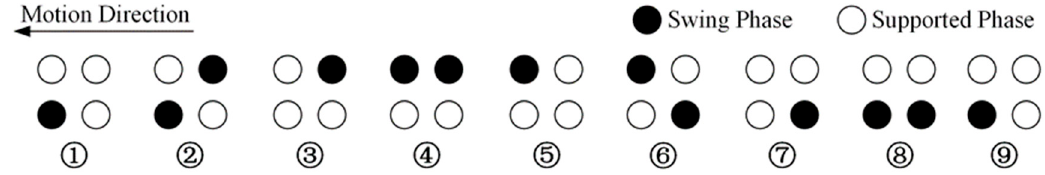
Figure 3. Goat locomotion gait on the slopes consisting of eight movements, which are ① the left front leg swung monophasically; ② the left front leg and the right hind leg swung biphasically; ③ the right hind leg swung monophasically; ④ the right hind leg and the right front leg swung bipha- sically; ⑤ the right front leg swung monophasically; ⑥ the right front leg and the left hind leg swung biphasically; ⑦ the left hind leg swung monophasically; ⑧ the left hind leg and the left front leg swung biphasically.